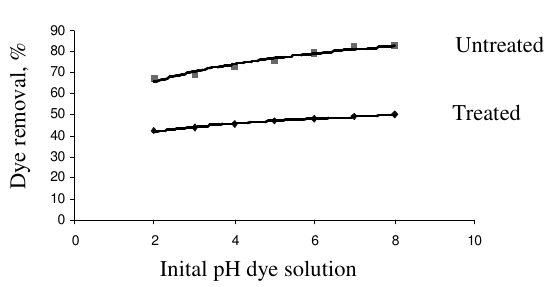
Figure 1. Effect of pH on adsorption of methylene